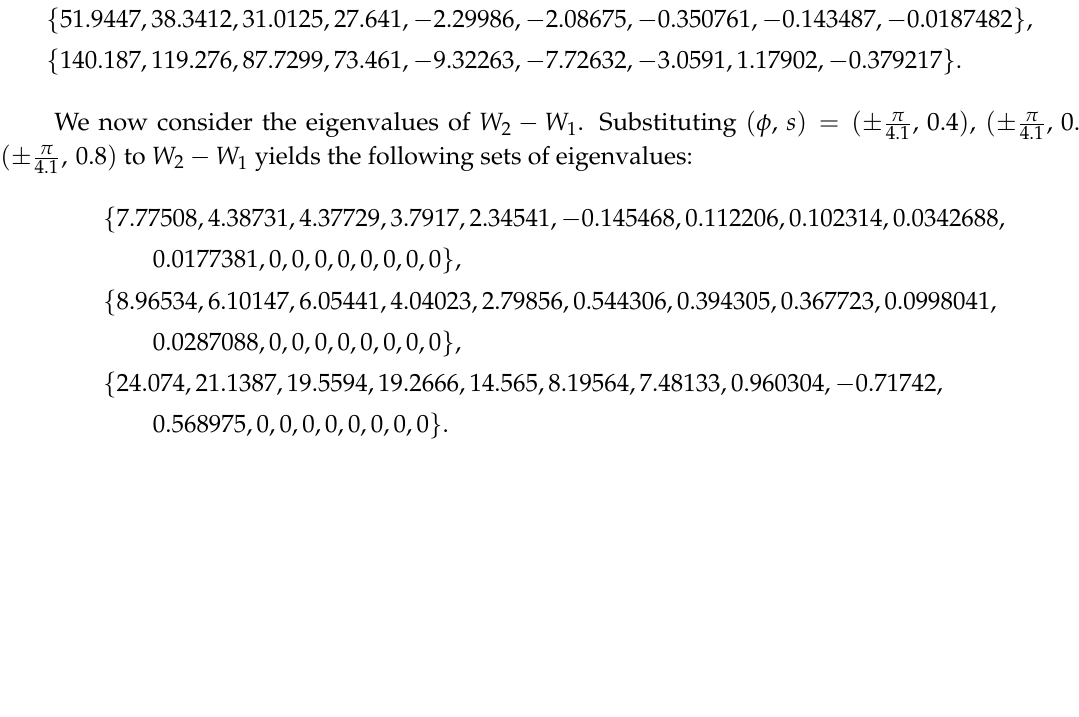
( A + B )( C + D ) A + B )( C + D ) (the blue domain) in −(cid:61) (cid:60) (cid:60) (cid:61) − (cid:60) (cid:61) −(cid:61) (cid:60)